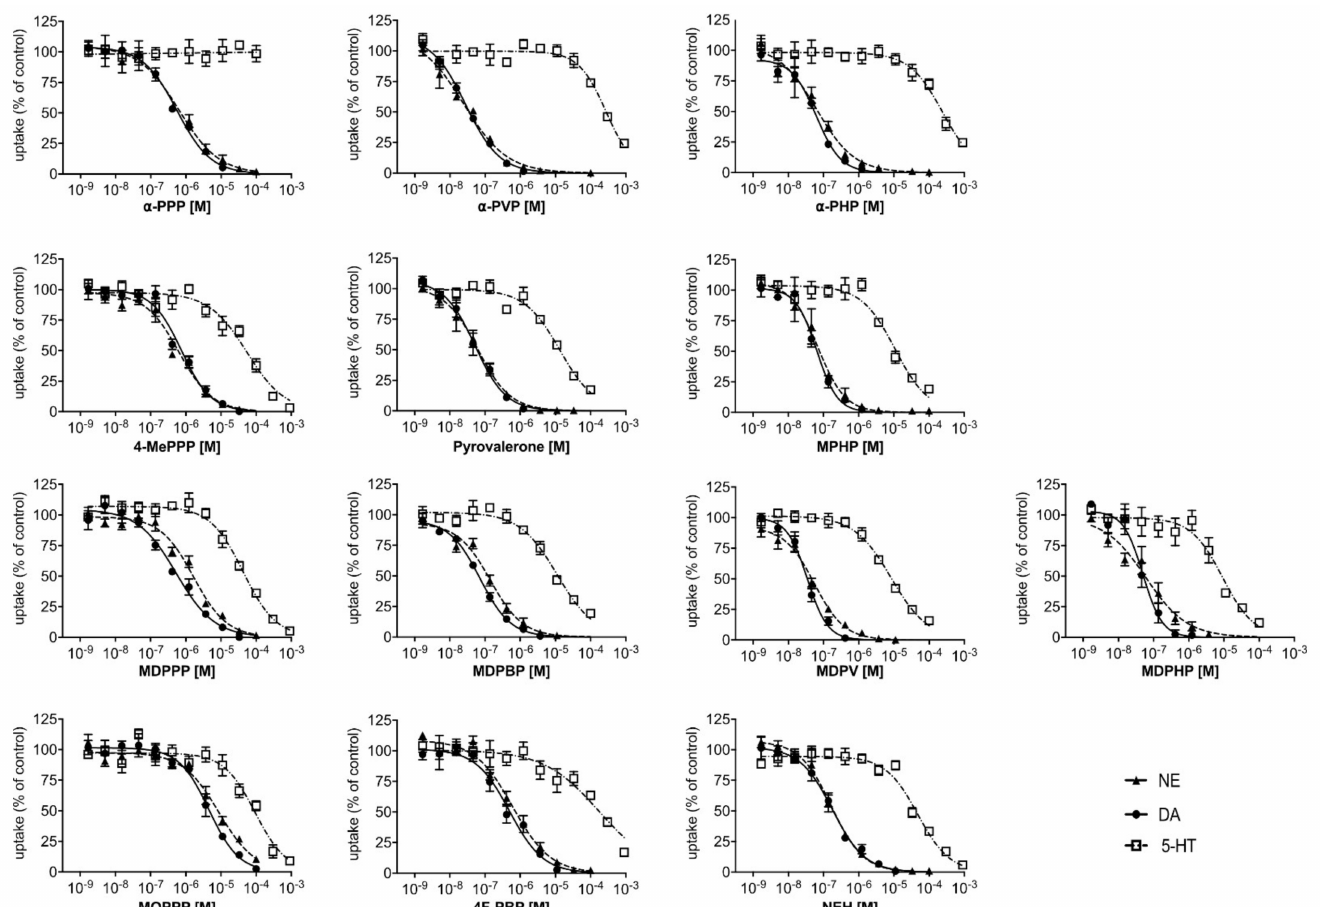
Figure 2. Monoamine uptake inhibition of pyrovalerone cathinones and NEH. Monoamine uptake inhibition of nore- pinephrine (NE), dopamine (DA), or serotonin (5 − HT) were assessed in human embryonic kidney 293 (HEK293) cells stably transfected with each corresponding uptake transporter (NET, DAT, or SERT, respectively). Curves were fitted by non-linear regression and data is shown as mean ± standard error mean (SEM) with corresponding IC 50 values for each compound presented in Table